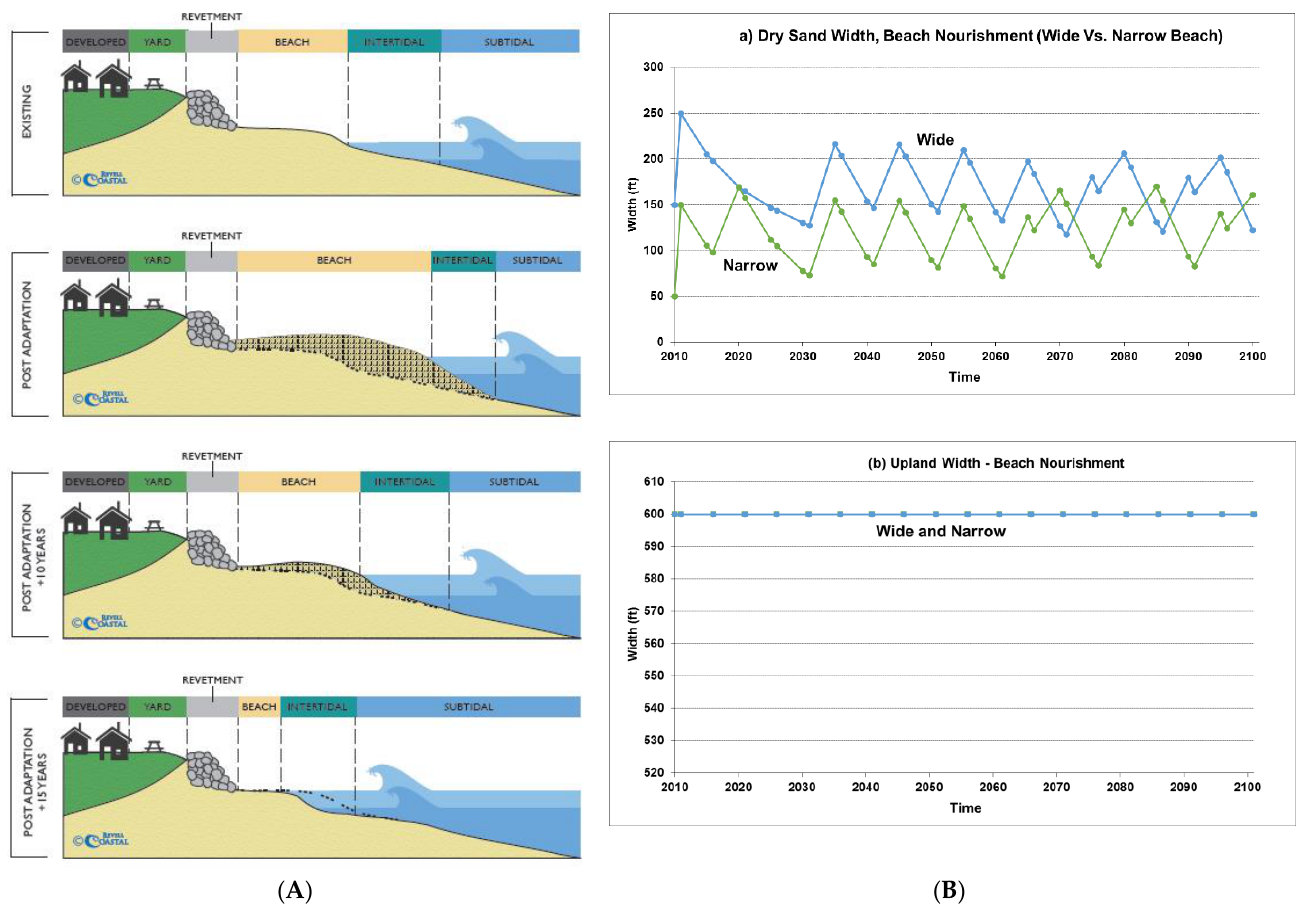
Figure 9. ( A ) Evolution of the beach nourishment strategy over time. Example does not illustrate the shortening time between nourishment cycles as sea level rises. ( B ) Dry sand beach width over time with armoring (wide vs. narrow beach) (Ba top plot); upland width over time with armoring (wide vs. narrow beach) (Bb bottom plot).